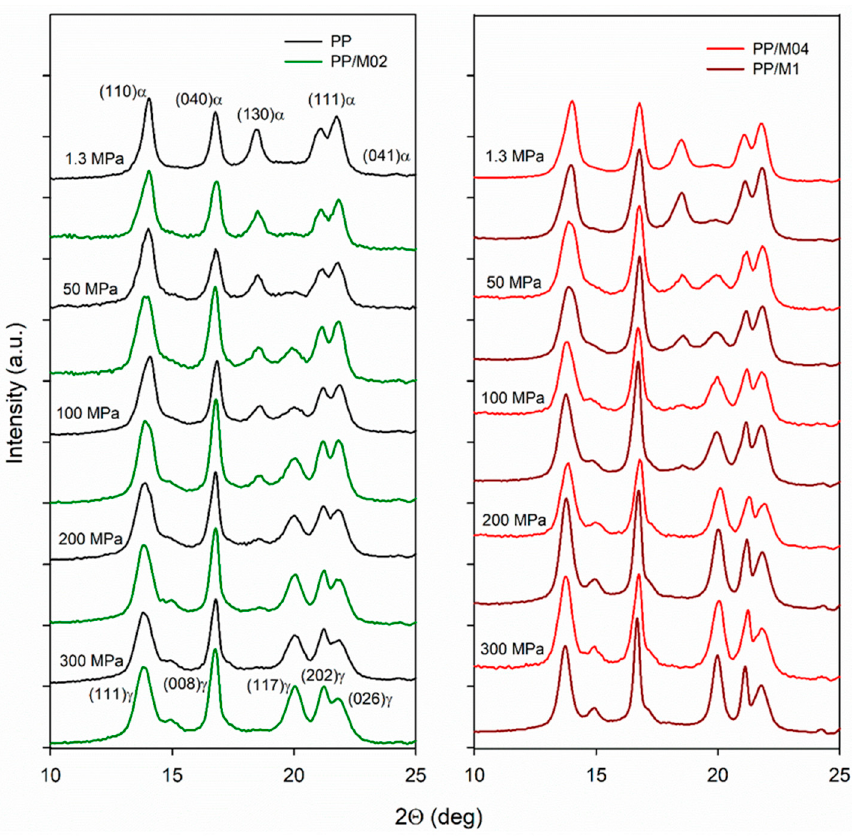
Figure 3. X-ray diffractograms, in 2 Θ range from 10 to 25°, of neat and nucleated PP crystallized during cooling under various pressures according to protocol I.